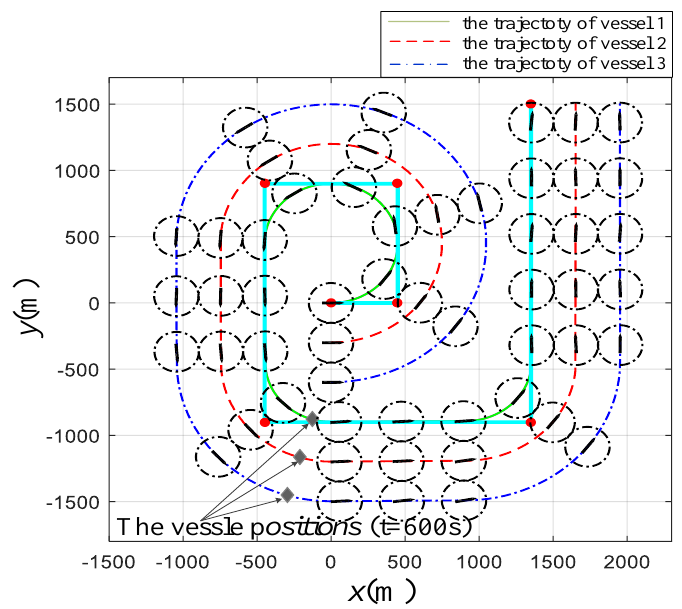
Figure 5. The position and orientation errors for the formation.